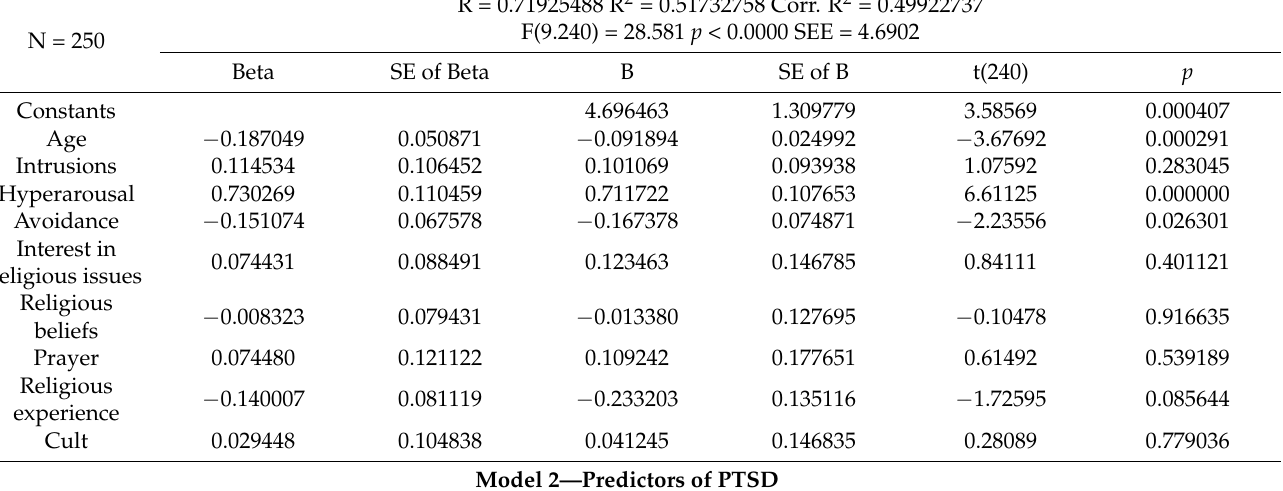
Table 3. Models and results of the multiple regression analysis. Model 1—Predictors of